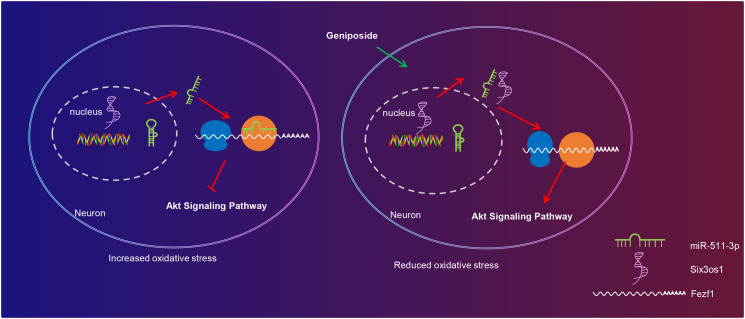
The molecular mechanism of GP treatment mediating oxidative stress in mice with depression-like behavior via the Six3os1/Fezf1/AKT. In CUMS-induced mice, miR-511-3p targets and inhibits Fezf1, thus stimulating oxidative stress of neurons. After GP treatment, Six3os1 expression is upregulated, which increases Fezf1 expression by binding to miR-511-3p and then activates AKT signaling pathway, thus alleviating oxidative stress in mice with depression-like behavior.